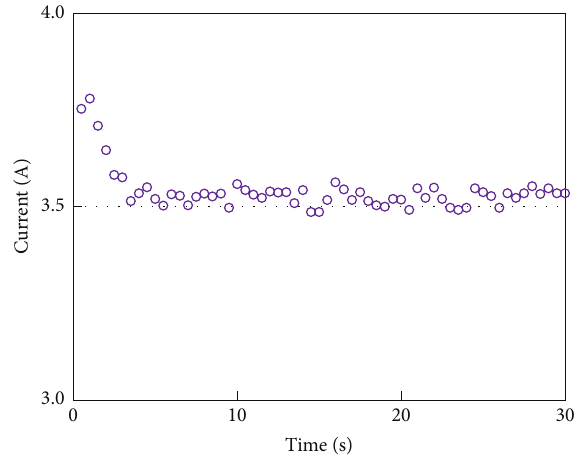
Figure 7: A typical current chart for 30 seconds after the knife mill starts without